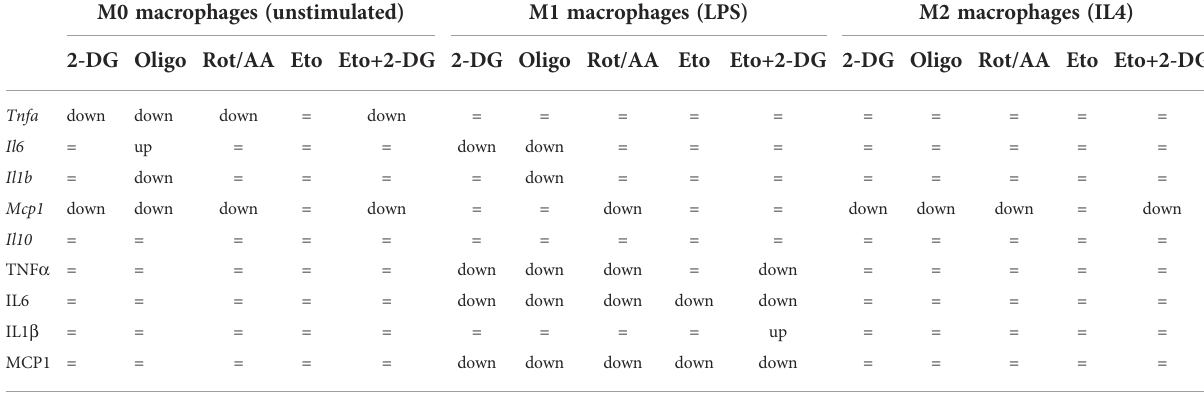
TABLE 1 Summary of effects of metabolic inhibitor pretreatments on gene expression and cytokine concentration in media from macrophages. M0 macrophages (unstimulated) M1 macrophages (LPS) M2 macrophages